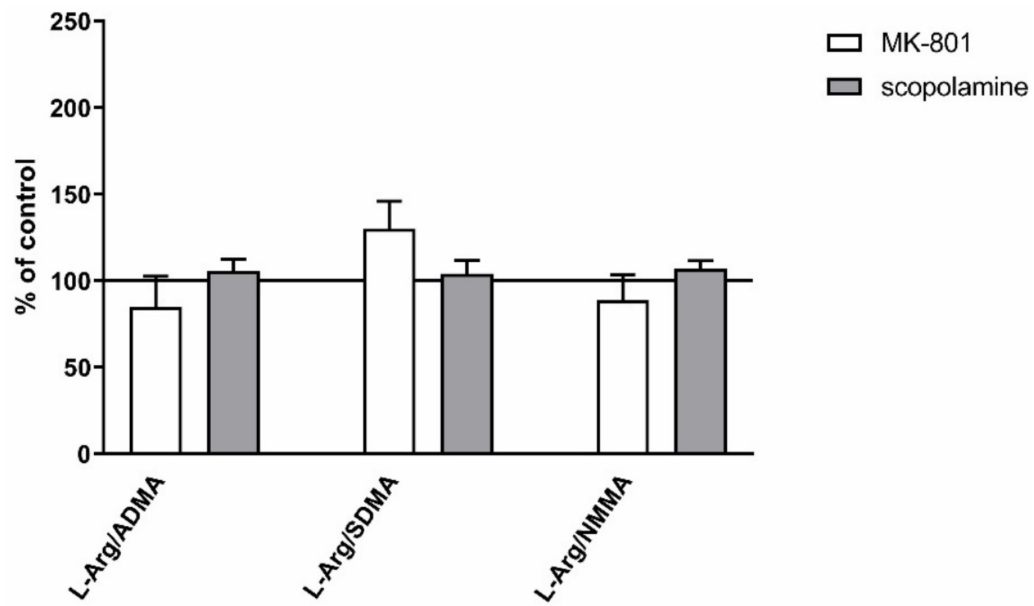
Figure 16. L-arginine (L-Arg)/ADMA, L-arginine/SDMA and L-arginine/NMMA ratios in plasma after acute administra- tion of MK-801 or scopolamine. Data are presented as means ±